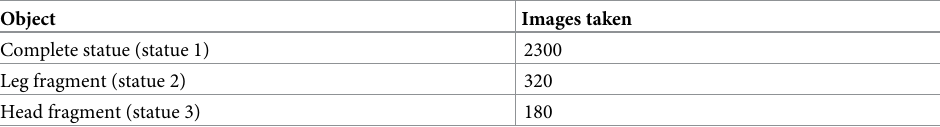
Table 1. Images used for the photogrammetric modelling of statue 1 from the Glauberg and some of its fragment. Object Images